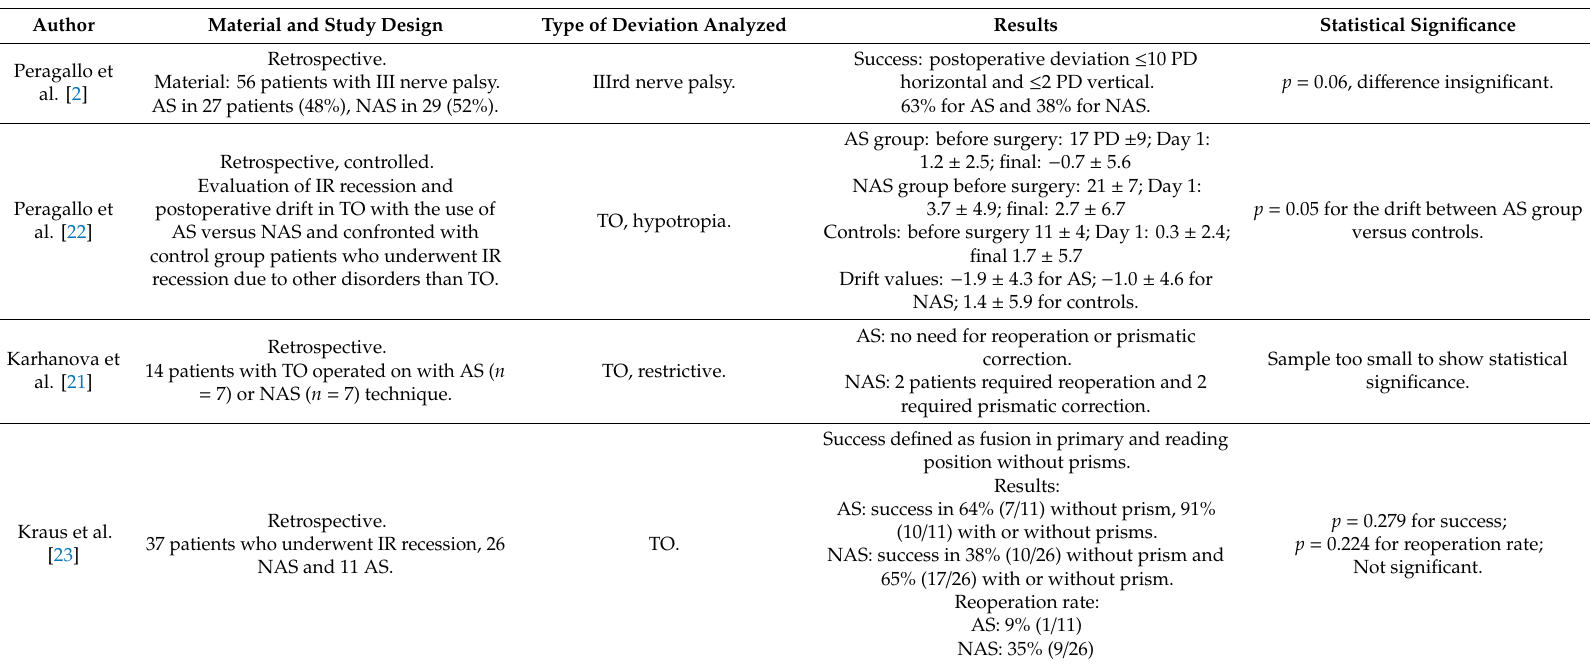
Table 3. Paralytic or restrictive strabismus